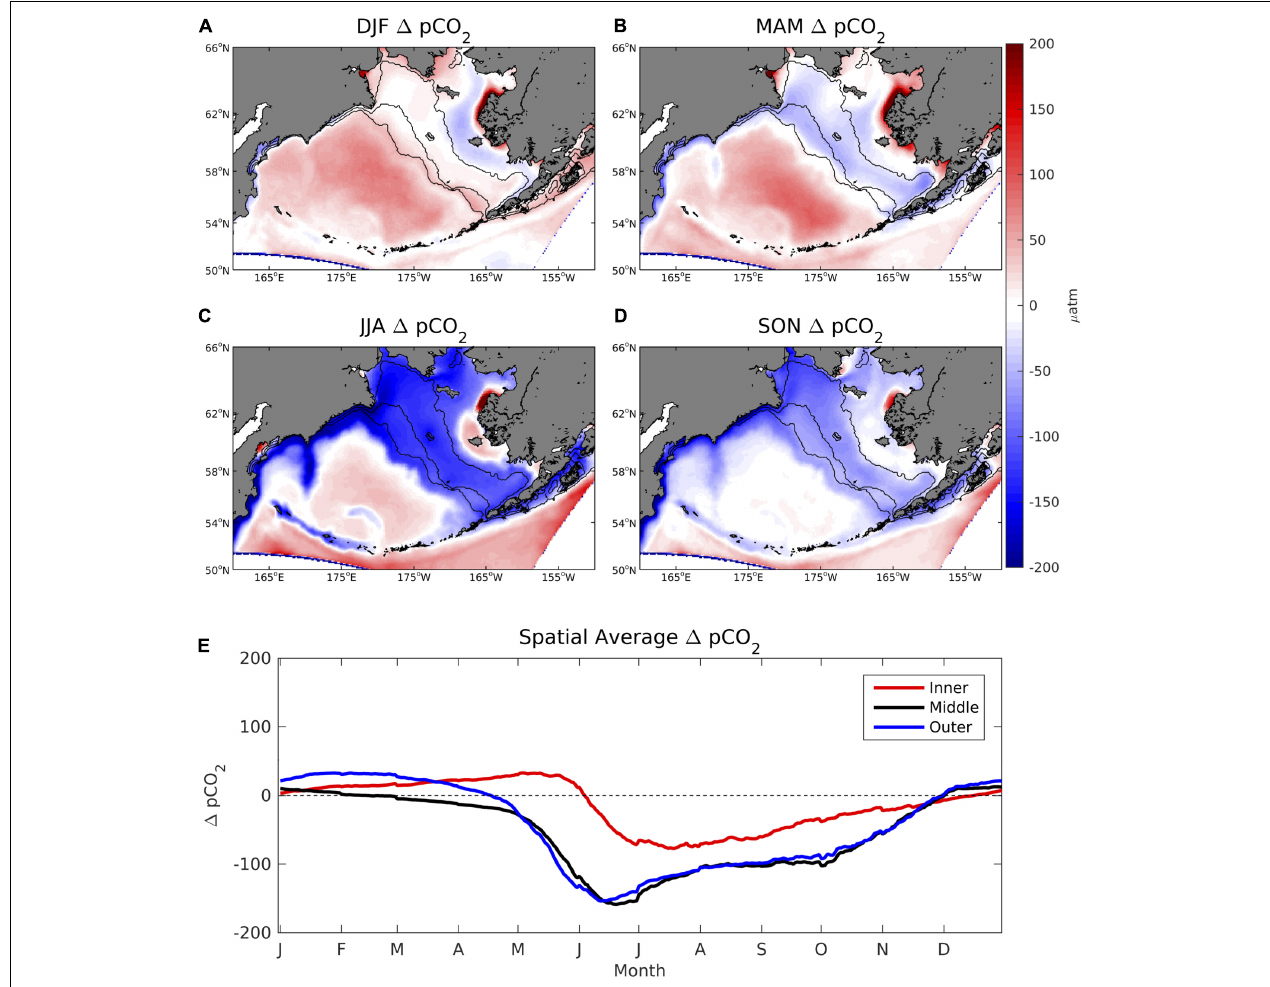
FIGURE 4 | (A–D) Seasonal plots of model (cid:49) p CO 2 averaged over the 2003–2012 timeframe and (E) time series of area-weighted spatial mean (cid:49) p CO 2 for the three shelf domains, denoted by the 50, 100, and 200 m isobath lines shown in Figure 1